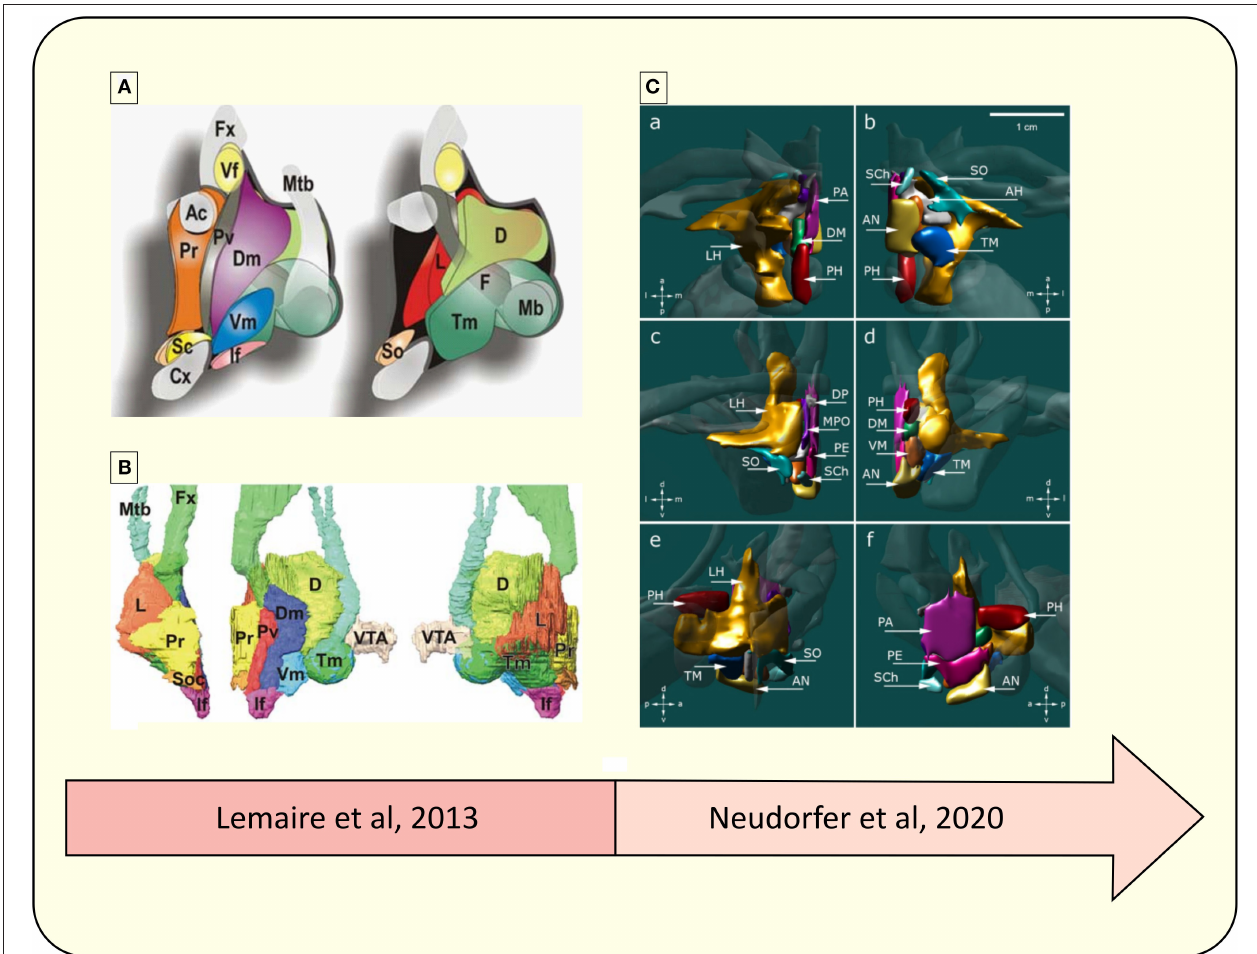
FIGURE 4 | Representative diagram of the advances in the parcellation of the hypothalamus. (A) Schematic drawing of hypothalamic nuclei, lateral view from the midline. Left, nuclei directly located under the wall of the third ventricle; right, more deeply located nuclei up to the lateral region ( 52). (B) 3D overview of hypothalamic nuclei, constructed from a 3D high-field MRI data set. Left, frontal view; middle, lateral view; right, medial view. VTA, ventral tegmental area; Ac, anterior commissure; D, dorsal or posterior nucleus: Dm, dorsomedial nucleus; Fx, fornix; F, fornix nuclei; If, infundibular (arcuate) nucleus; L, lateral nucleus; Mb, mammillary body; Mtb, Fmillo-thalamic bundle; Cx, optic chiasma; Pv, paraventricular nucleus; Pr, preoptic nuclei; Sc, suprachiasmatic (ovoid) nucleus; Vf, ventricular foramen; So, supraoptic (tangential) nucleus; Tm, tuberomamillaris (mamilloinfundibularis) nucleus; Vm, ventromedial (tuber principal) nucleus (52). (C) 3D reconstruction of hypothalamic nuclei and their neuroanatomical relationships. (a) top view, (b) bottom view, (c) frontal view, (d) occipital view, (e) sagittal view depicting the outer surface of hypothalamic nuclei, (f) sagittal view depicting the inner surface of hypothalamic nuclei. AH, anterior hypothalamic area; AN, arcuate nucleus; DP, dorsal periventricular nucleus; DM, dorsomedial hypothalamic nucleus; LH, lateral hypothalamus; MPO, medial preoptic nucleus; PA, paraventricular nucleus; PE, periventricular nucleus; PH, posterior hypothalamus; SCh, suprachiasmatic nucleus; SO, supraoptic nucleus; TM, tuberomammillary nucleus; VM, ventromedial nucleus